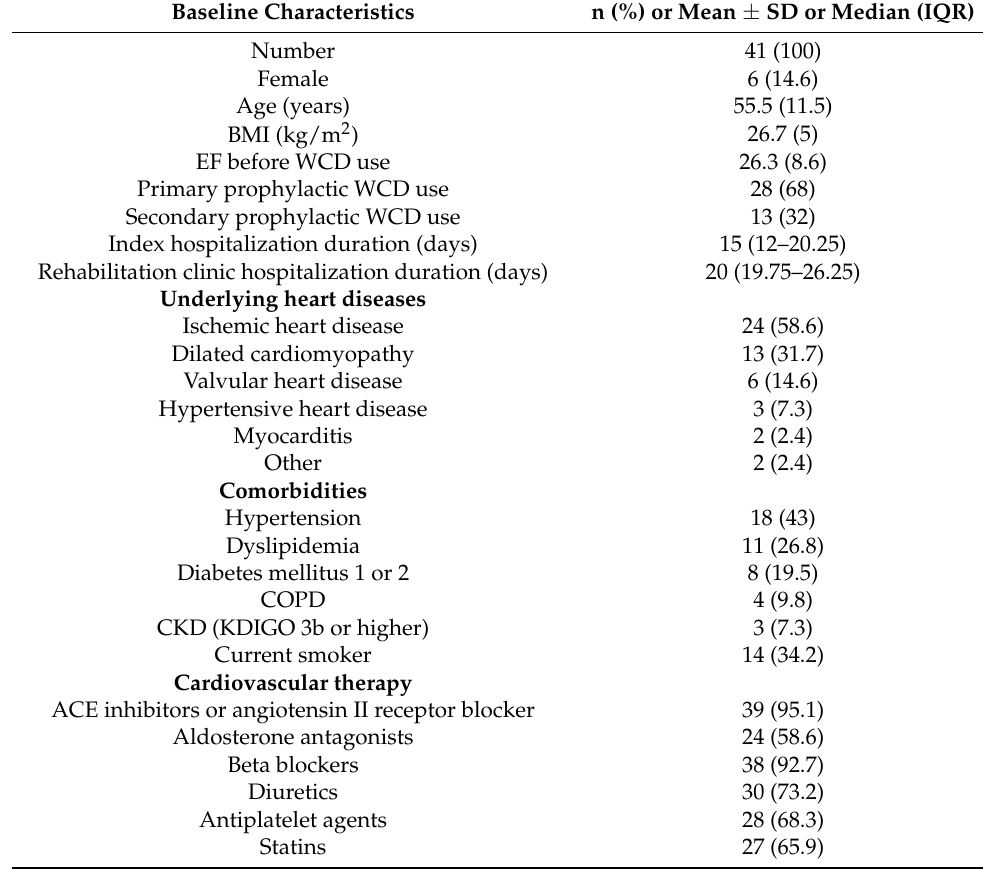
Table 1. Baseline characteristics of study